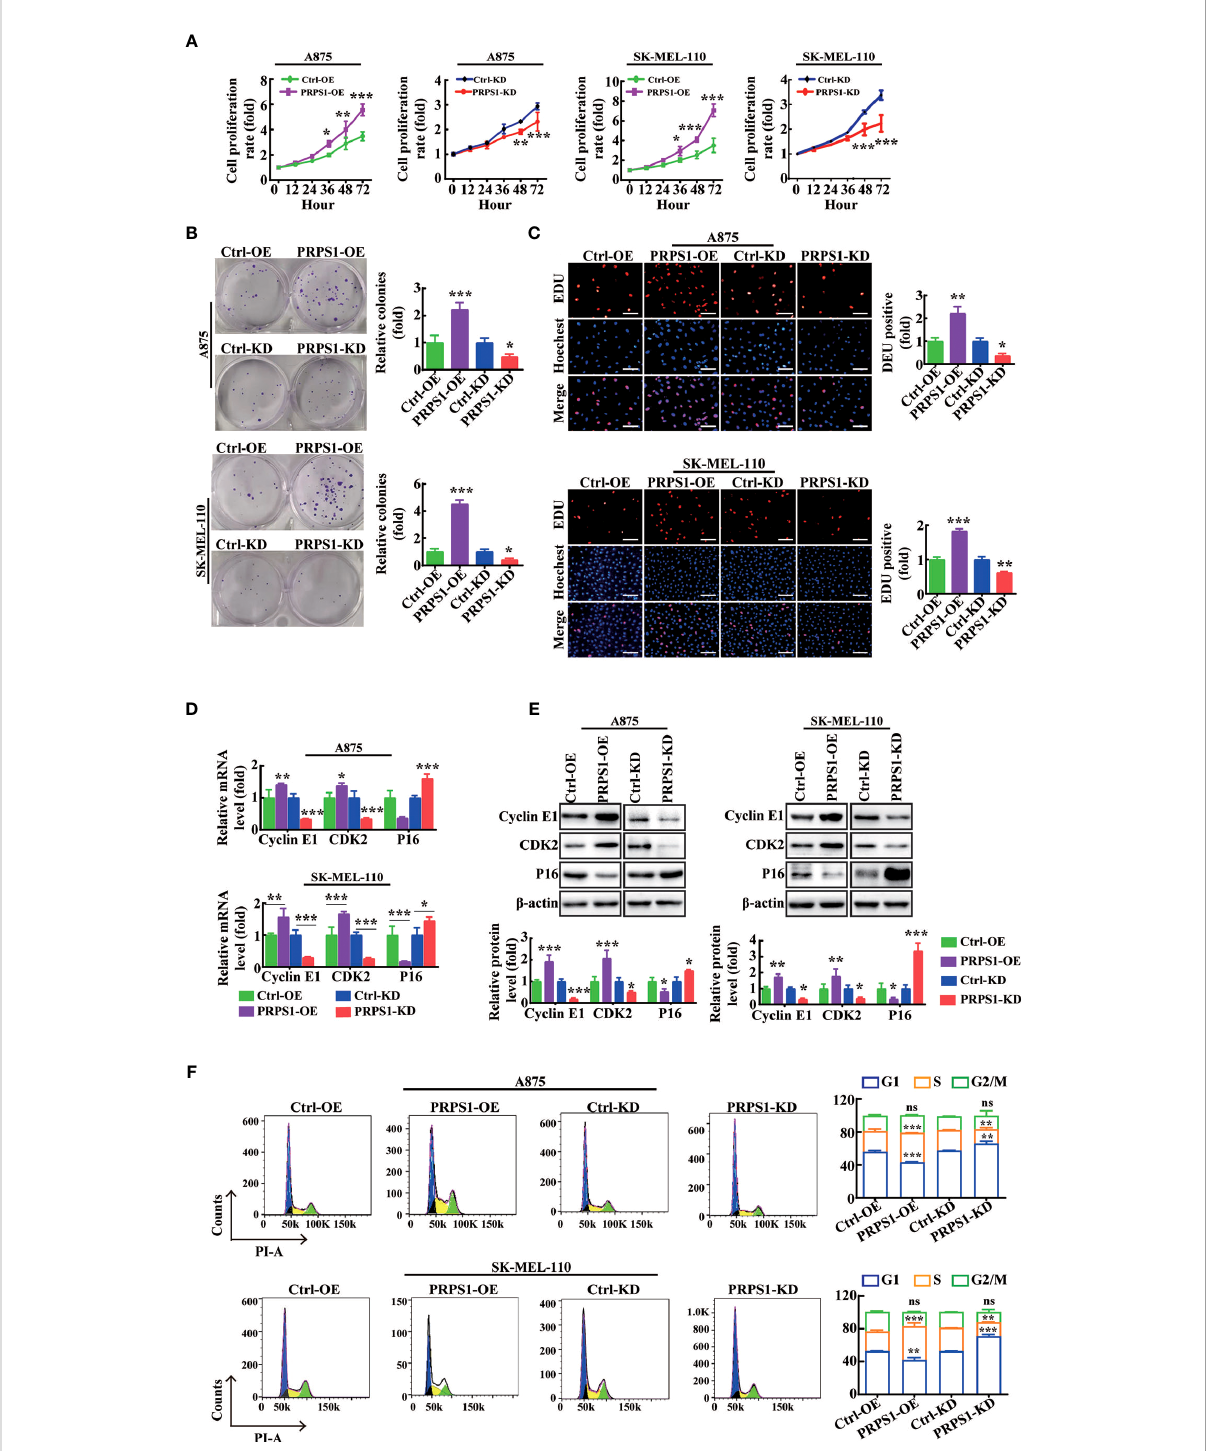
FIGURE 2 PRPS1 promotes melanoma cells proliferation in vitro. (A – C) The proliferation rate of A875 and SK-MEL-110 cells with PRPS1 overexpression or knock-down and the corresponding control cells were detected by MTS assay (A) and cells colony formation assay (B) and EDU method (C) scale bars = 50 m m. (D – F) The effects of PRPS1 on the phase distribution of melanoma cell cycle at mRNA level, protein level and cell level were analyzed by qPCR (D) , western blotting (E) and fl ow cytometry (F) . The data represent three independent experiments. Each bar represents mean ± SD. p values were calculated using a student t-test (*p < 0.05, **p < 0.01, ***p < 0.001 vs. each control). ns mean no signi fi cant